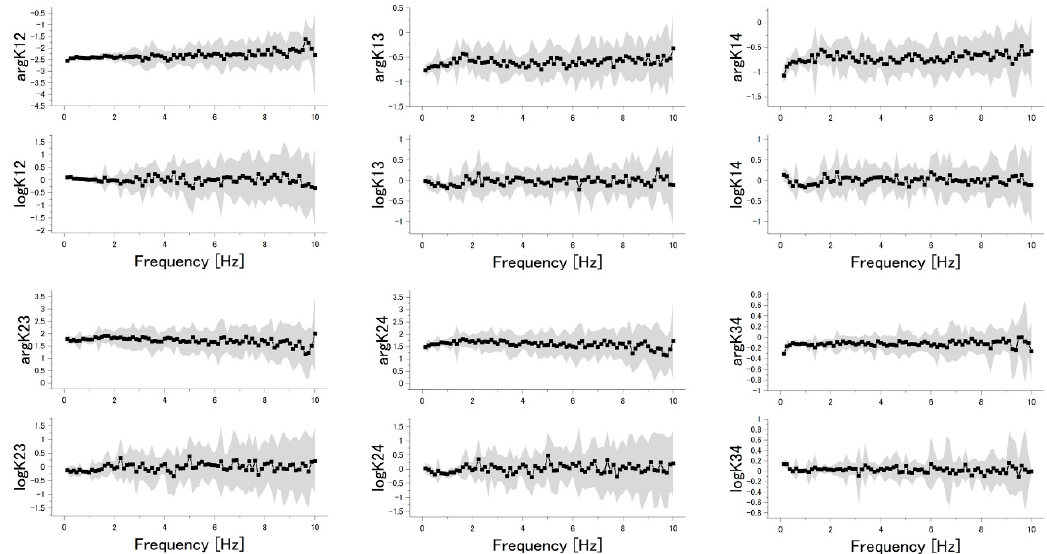
Figure 2. Transfer function ratios (TFRs) of the data obtained through Protocol-5. Mean values and standard deviations of log | K m,n | and arg K m,n are plotted as squares and shaded areas, respectively. standard deviations of log| K m,n | and arg K m,n are plotted as squares and shaded areas, respectively. Water was used as a Water was used as a sample.